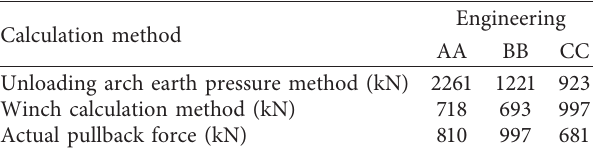
Figure 1: Cross section of product oil pipeline crossing project. Table 1: Comparison of pullback forces in three